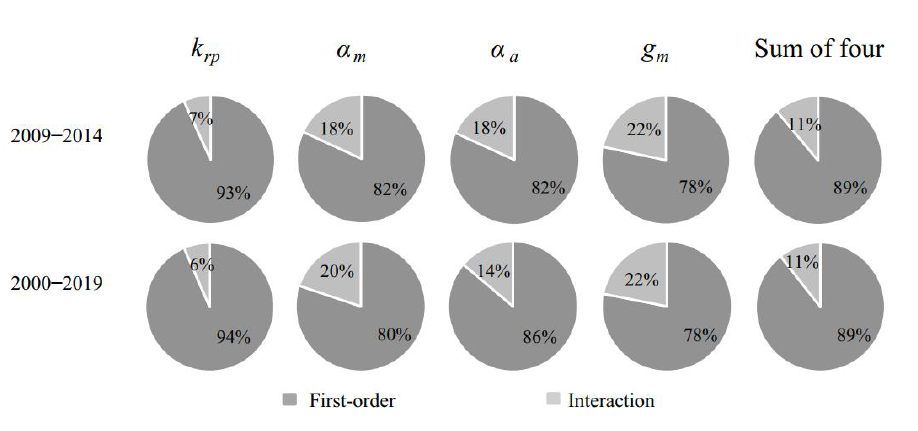
Table 3. Correlation coefficients between the Morris method ( μ* ) and EFAST ( ST i ).